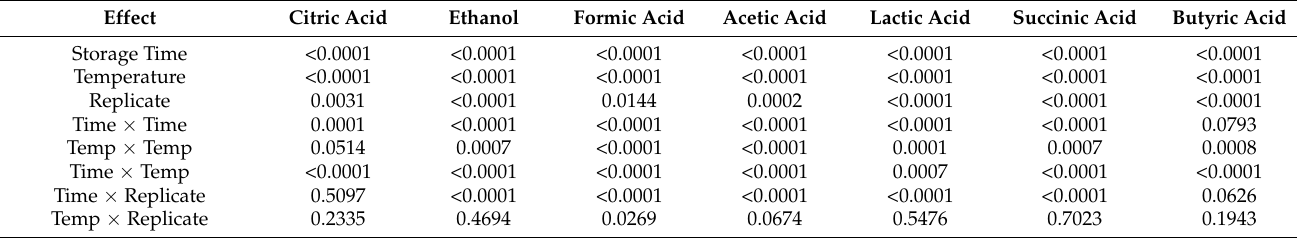
Figure 2. Targeted NMR metabolomics analysis results. Each row shows millimolar concentrations of one significantly changing metabolite versus storage time in days at 4 different storage temperatures. Citric acid uses a linear scale, while all other metabolites use a logarithmic scale on the y -axis (concentrations). The y -axes are identical for all plots in one row, while the x -axes are identical for all plots in one column. Table 1. ANOVA significance table for the effects of storage time, storage temperature, and biological replicate (batch) and their interaction and square terms on metabolite concentrations. Shown are p -values.